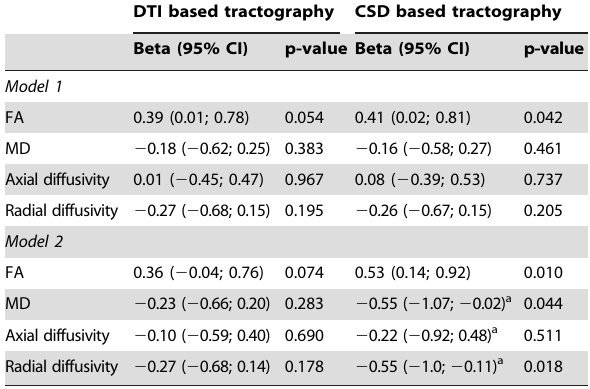
Model 2: Model 1 + adjustment for the planar diffusion coefficient, reflecting the degree of fiber organization complexity. Regression coefficients obtained with DTI and CSD based FT did not differ significantly, assessed with Steiger’s